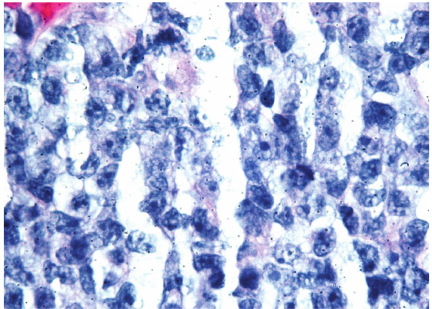
Figure 2: Minute fragment of core biopsy with morphology consis- tent with an intermediate to large cell aggressive T-cell lymphoma. These neoplastic cells were strongly positive for CD25 supporting the diagnosis of ATL.